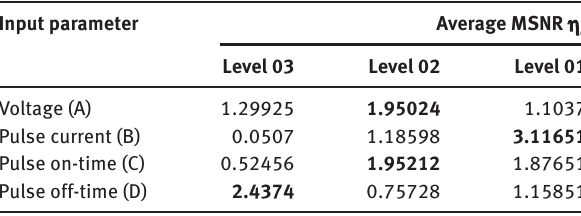
Table 17: The average MSNR for each input parameter in different levels in the machining of 2024 alloy.